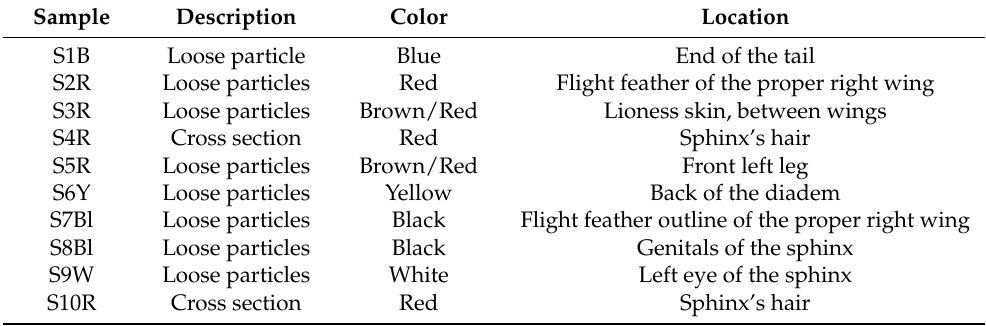
Table 1. List of micro-samples removed from the sphinx, with corresponding description and sampling